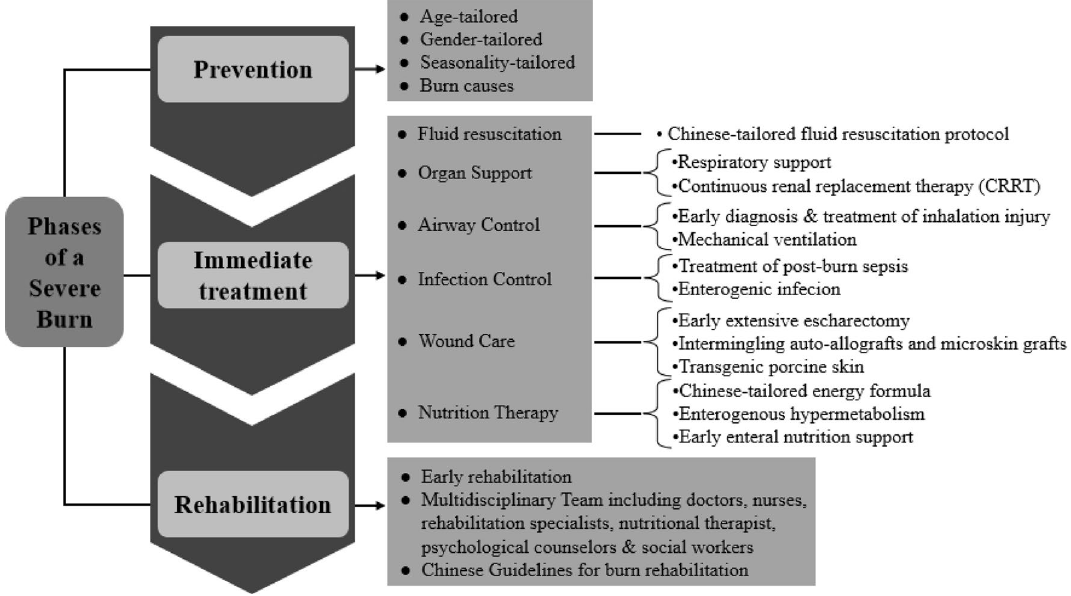
Figure 4. Burn prevention and management